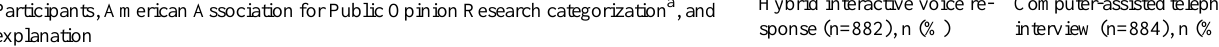
Table 1. Final disposition code by study arm (computer-assisted telephone interview vs hybrid interactive voice response) among female cell phone owners in Burkina